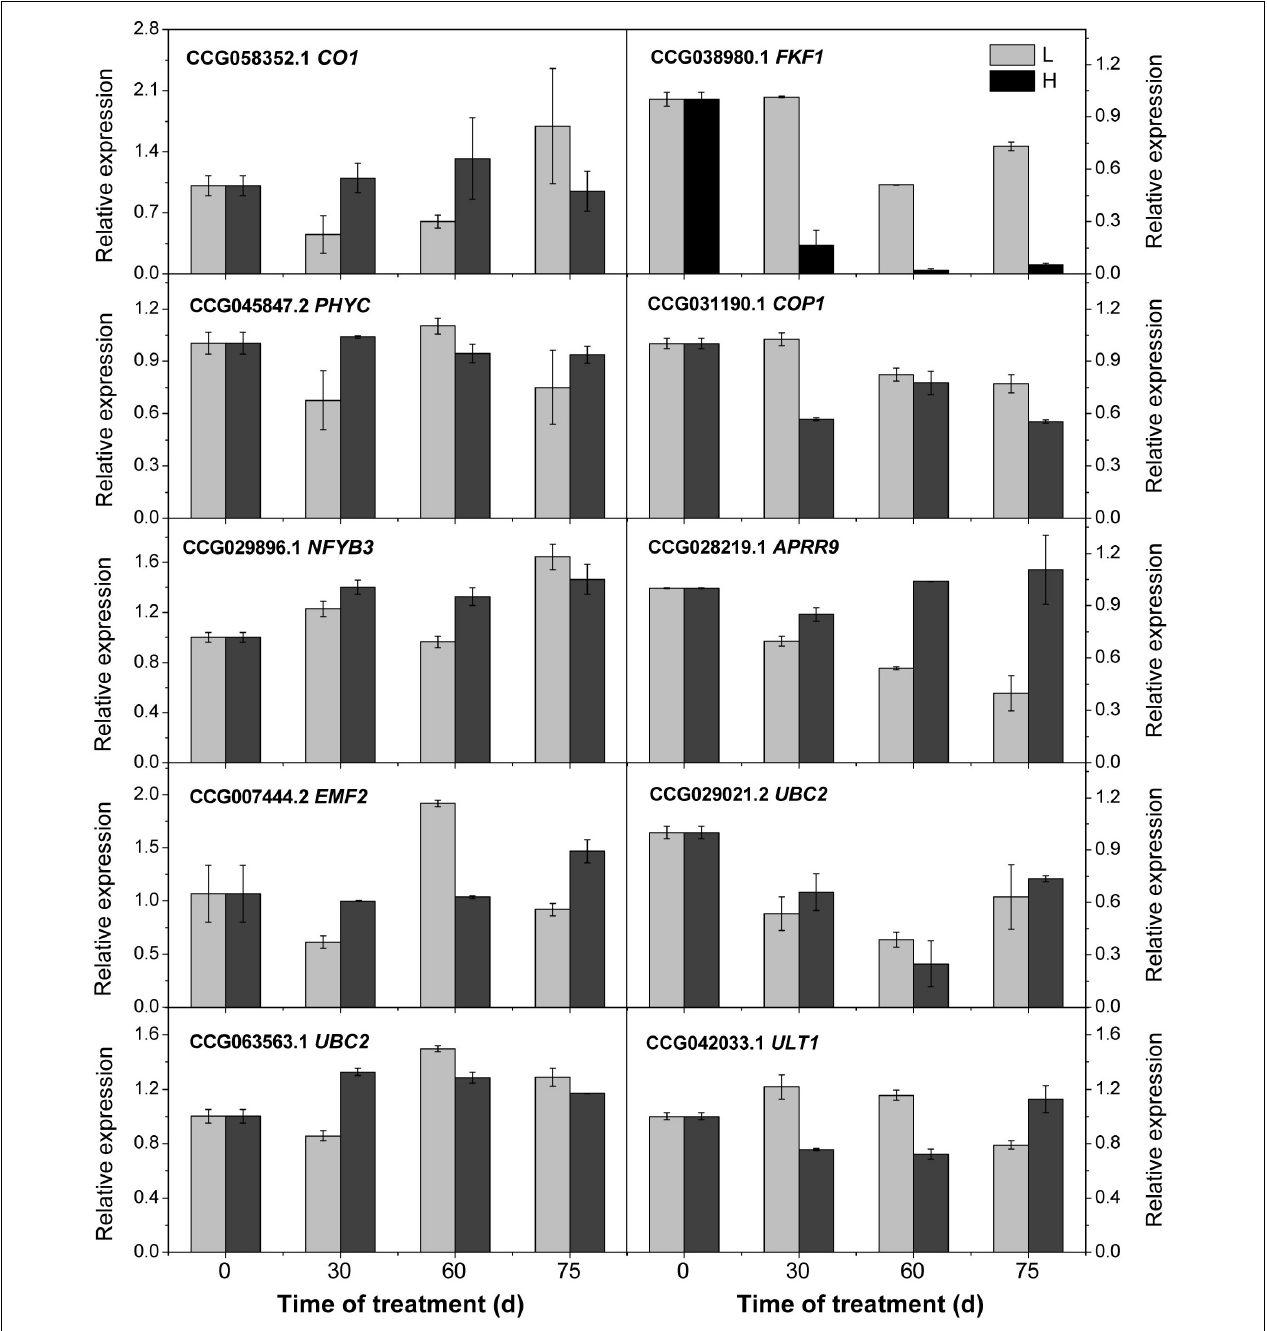
FIGURE 6 | Relative expression of the candidate genes revealed by quantitative real-time PCR. L and H indicate the low-temperature and high-temperature treatment, respectively. The data are the means of three biological replicates, and the bars represent SEs. The litchi homolog β -actin was used as a reference